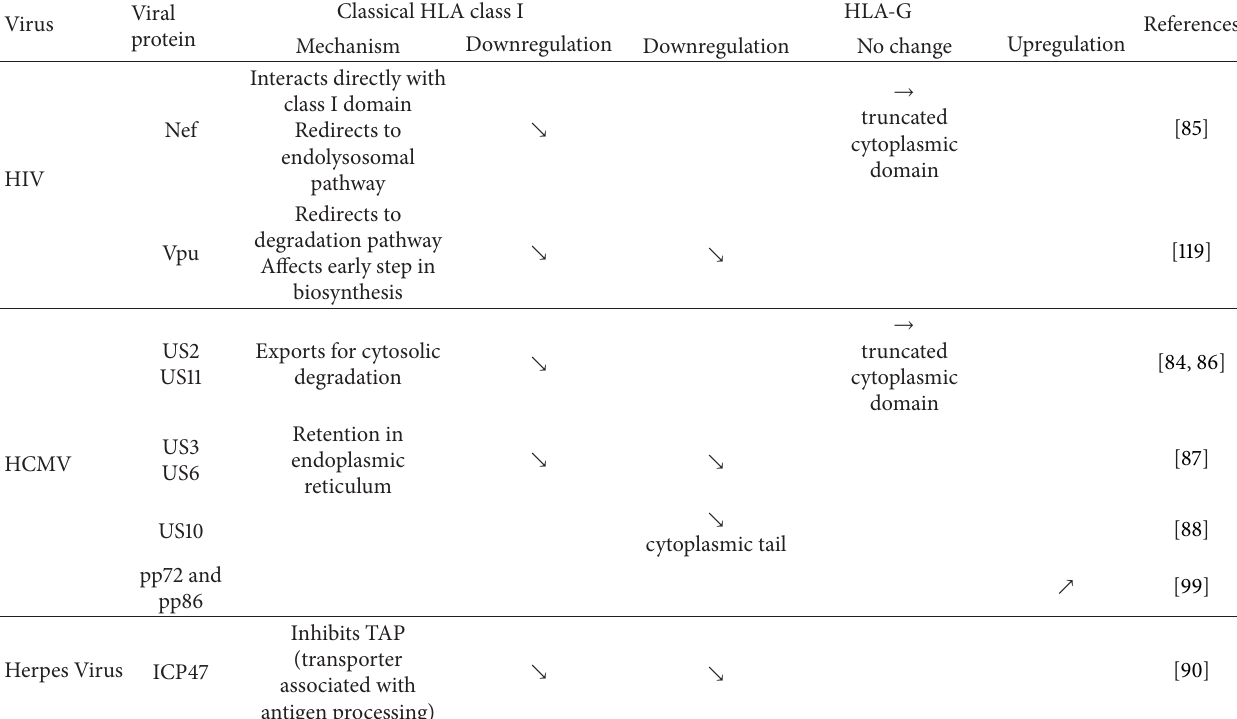
Table 3: Interference of viral proteins with HLA-G intracellular trafficking; comparison with classical HLA class I molecules.